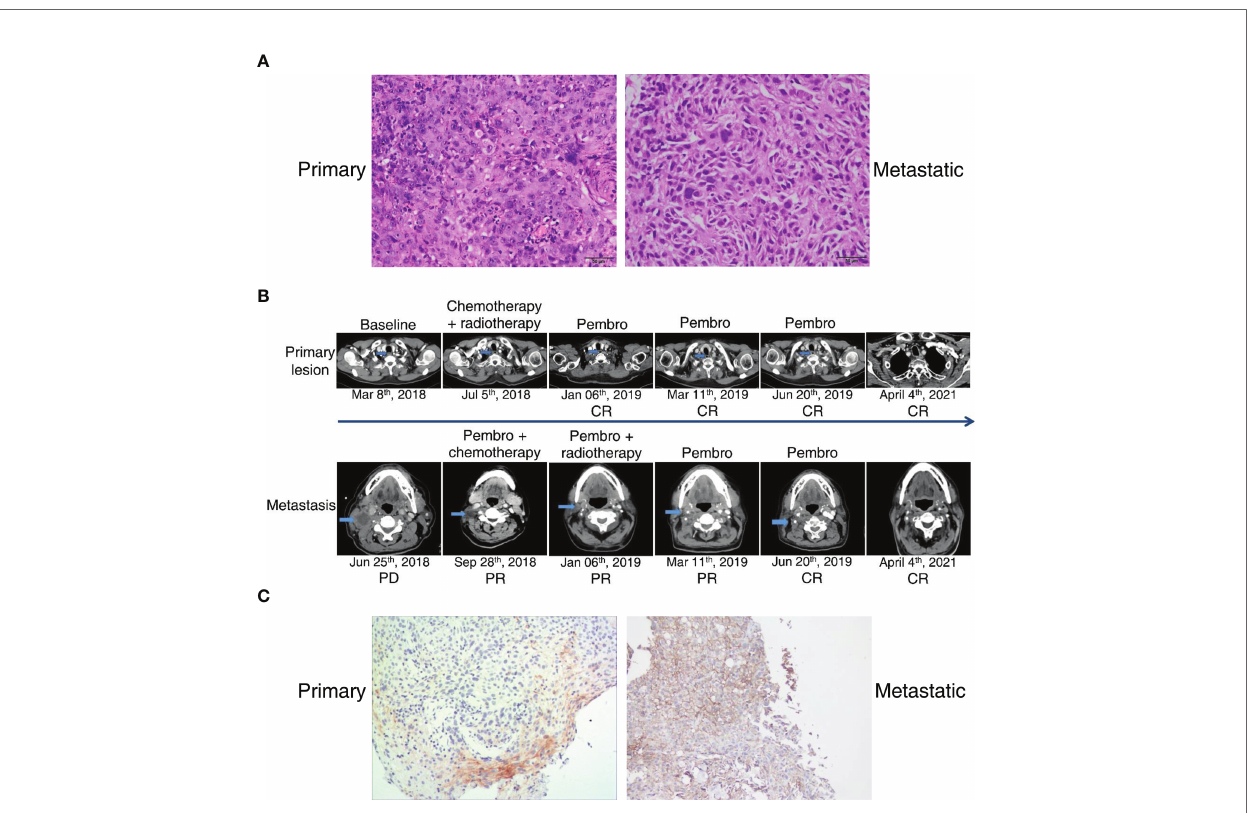
FIGURE 1 | Pathological results, radiological images, and PD-L1 assay of an esophageal squamous carcinoma patient with divergent MSI status between primary and metastatic lesions. (A) Histology of his primary and metastatic tumors. Magni fi cation, ×200. (B) Representative CT images associated with his clinical outcomes during the whole treatment. Outcomes were valuated according to RECIST 1.1 criteria. (C) IHC staining with anti-PD-L1 antibody (SP142). Magni fi cation,